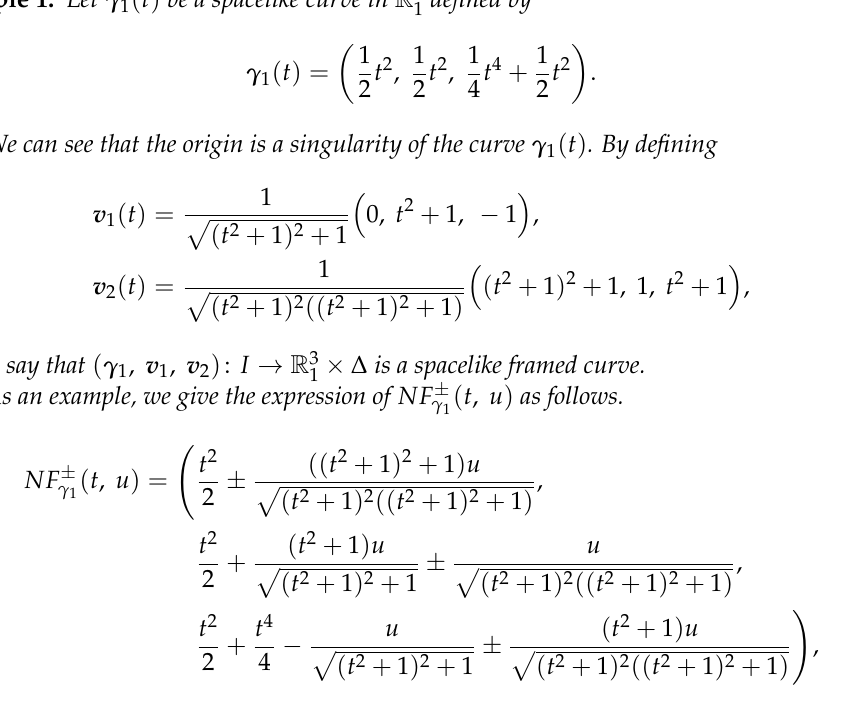
Figure 3. γ 1 ( t ) and NF − γ